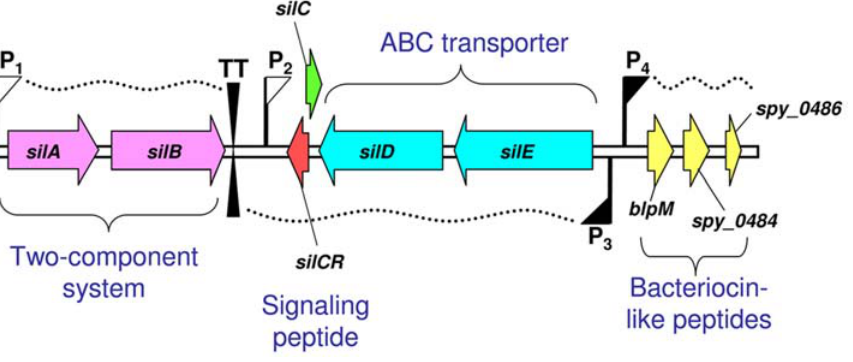
Figure 1. Transcriptional organization of the sil locus as previously deduced. sil is known to contain three polycistronic transcriptional units: silA/B encoding the TCS SilA-SilB, silE/D/CR encoding the ABC transporter system (SilD/E), plus the signaling peptide SilCR, and blp encoding the bacteriocin-like peptides BlpM, spy_0484 and spy_0486 . The transcription of the above-mentioned units is initiated from P 1 , P 3 , and P 4 promoters, respectively. The monocistronic transcript of silC is initiated from the P 2 promoter. Promoters induced and non-induced by SilCR are illustrated by filled and empty flags, respectively. Arrows indicate genes; waved-dotted lines represent transcripts; TT stands for a transcriptional terminator.